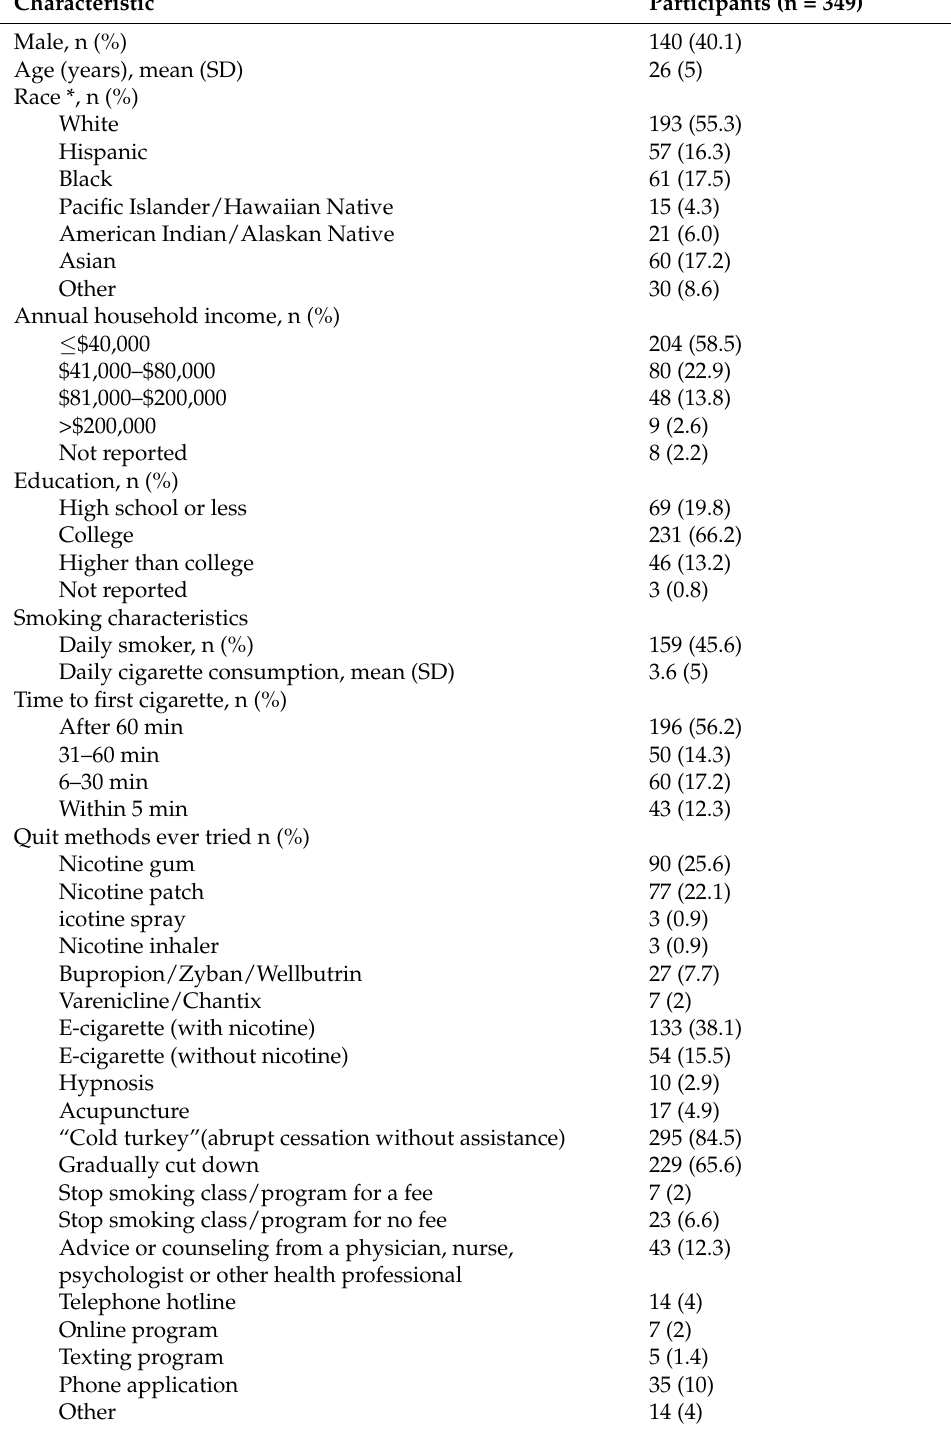
Table 1. Characteristics of Ready to Quit Participants Completing the Baseline